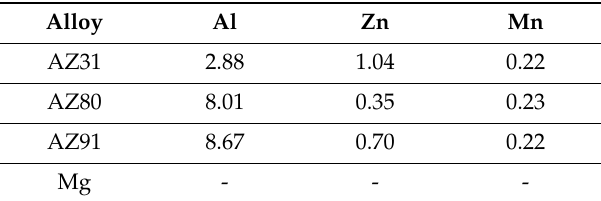
Table 1. Chemical analysis in wt% (Mg in balance).